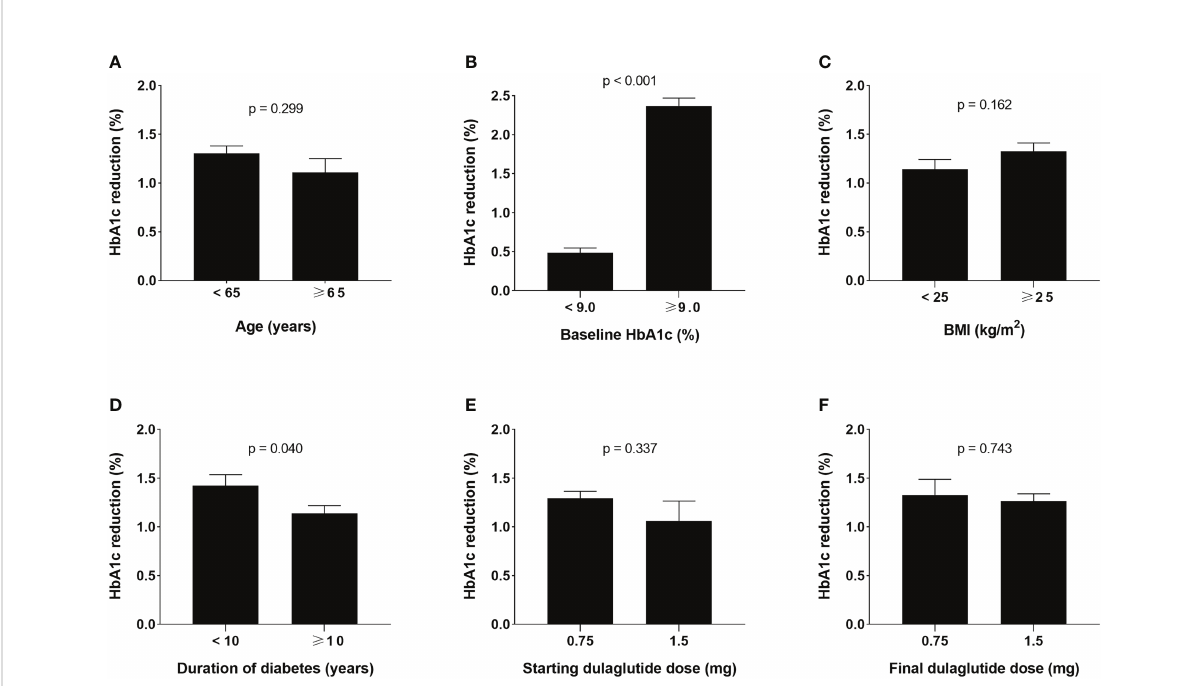
FIGURE 3 Glucose-lowering effects of dulaglutide among subgroups. Subgroup analyses for changes in HbA1c levels according to (A) age, (B) baseline HbA1c, (C) BMI, (D) duration of diabetes, (E) initial dulaglutide dose, and (F) fi nal dulaglutide dose. Data are presented as mean ± standard error. HbA1c, glycosylated hemoglobin; BMI, body mass